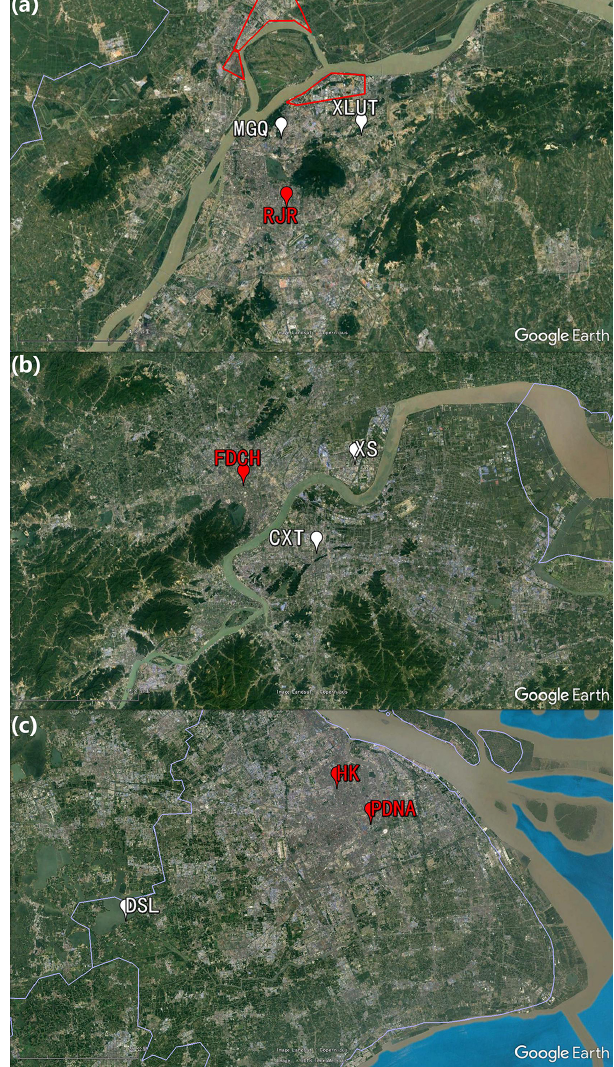
Figure 5. Maps of Nanjing (a) , Hangzhou (b) , and Shanghai (c) . The suburban sites are marked using white, the downtown sites are marked using red, and the industrial zones are denoted using red